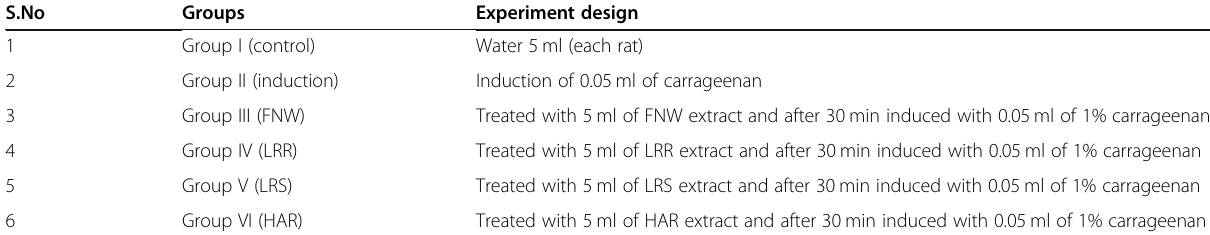
Table 1 Experimental design for anti-inflammatory activity